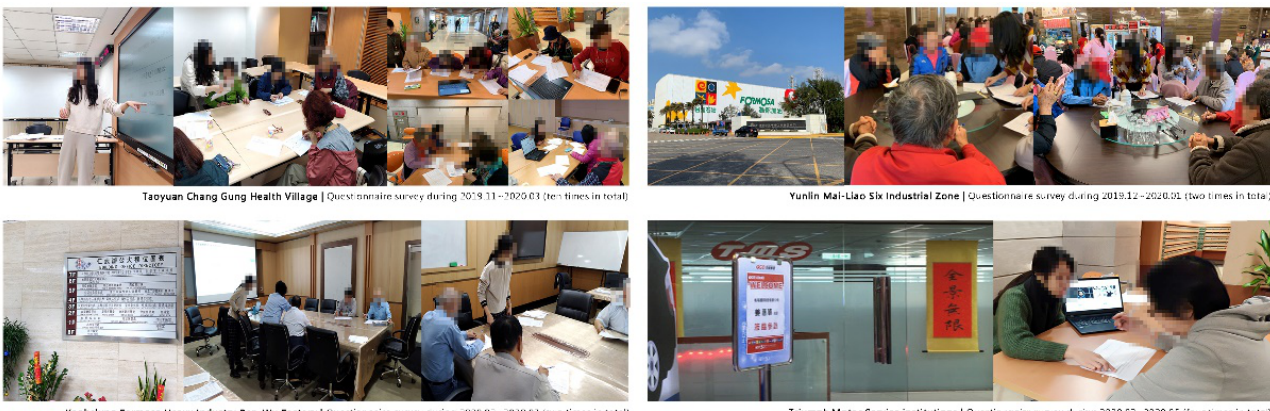
Figure 4. The implementation process of the questionnaire survey.